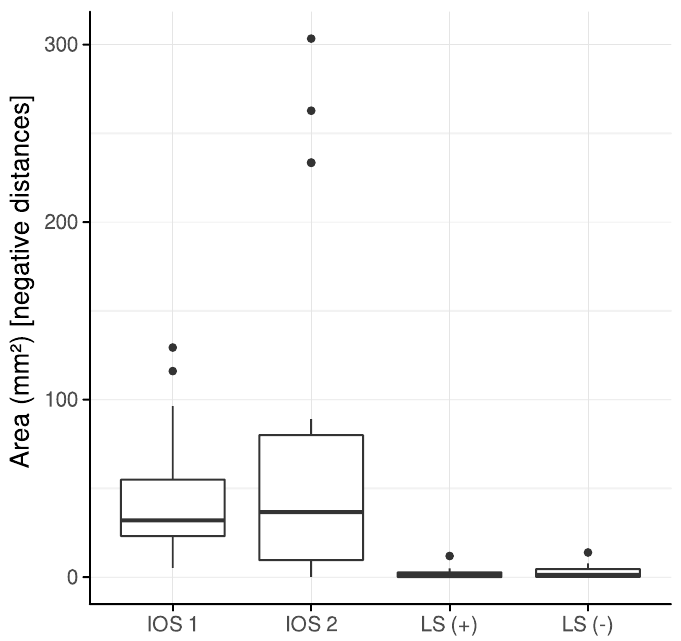
Figure 4. Area of intersection among initially aligned partial-arch scans.